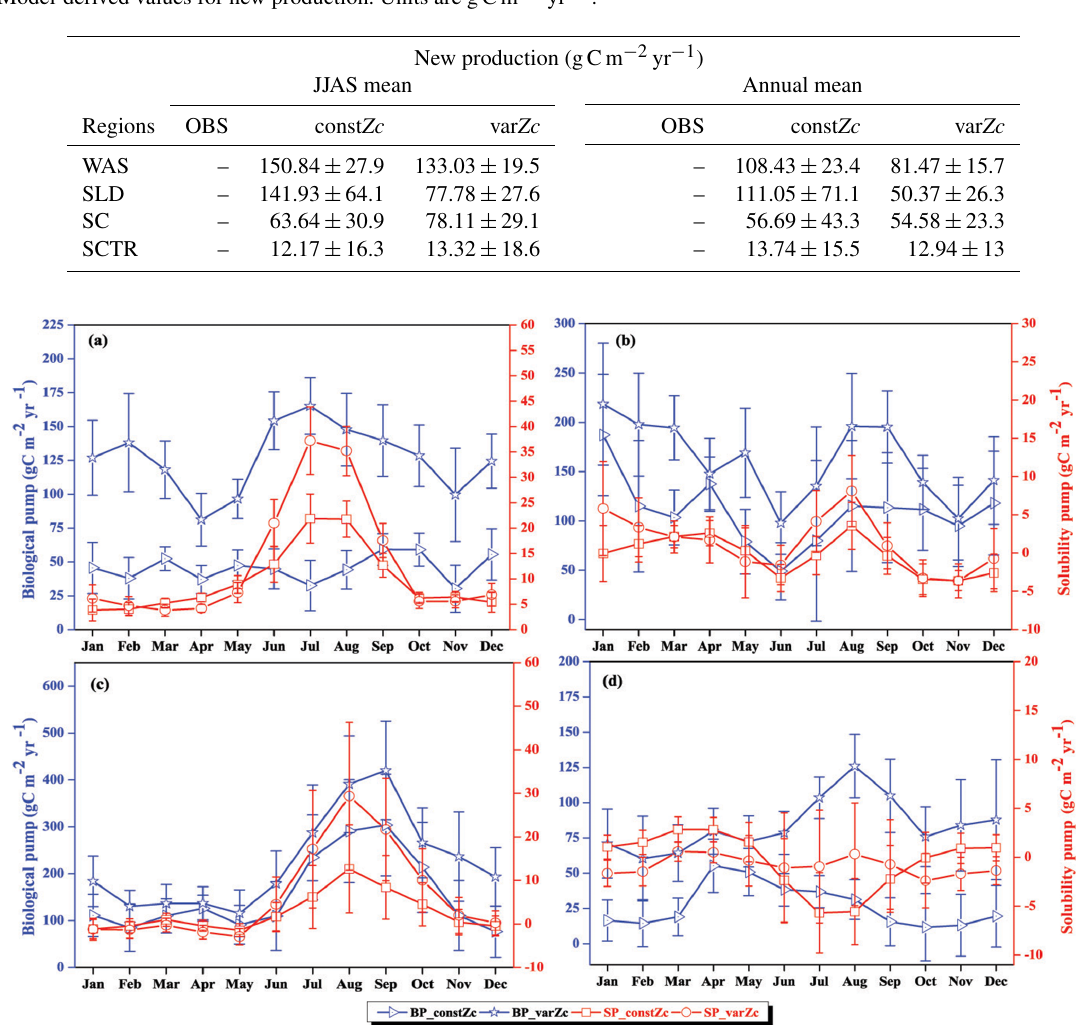
Figure 9. The strength of the biological pump (BP, blue lines) and solubility pump (SP, red lines) from const Zc and var Zc simulations for (a) WAS (b) SLD (c) SC and (d) SCTR. The left axis shows the biological pump and the right axis shows the solubility pump. Error bar shows standard deviations of individual months over the years 1990–2010. Units are gCm − 2 yr − 1